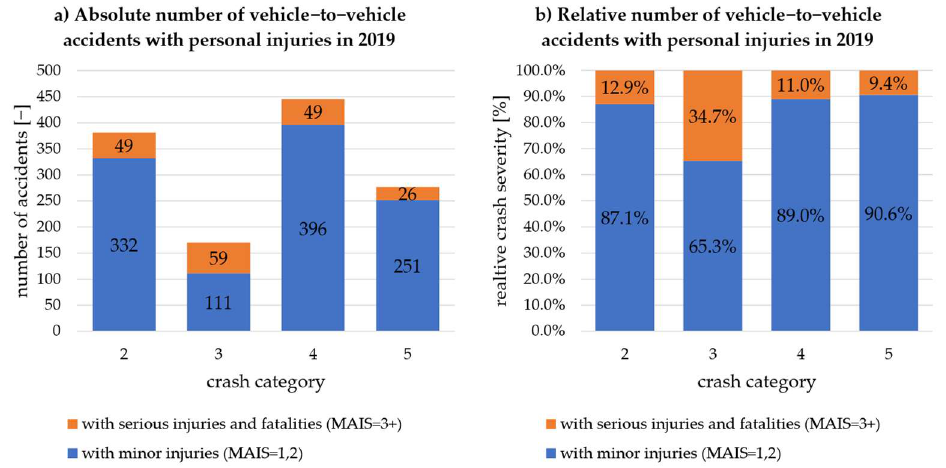
Figure 6. Vehicle-to-vehicle accidents with personal injuries in 2019 according to CISS [19]: ( a ) absolute number; ( b ) relative frequency.